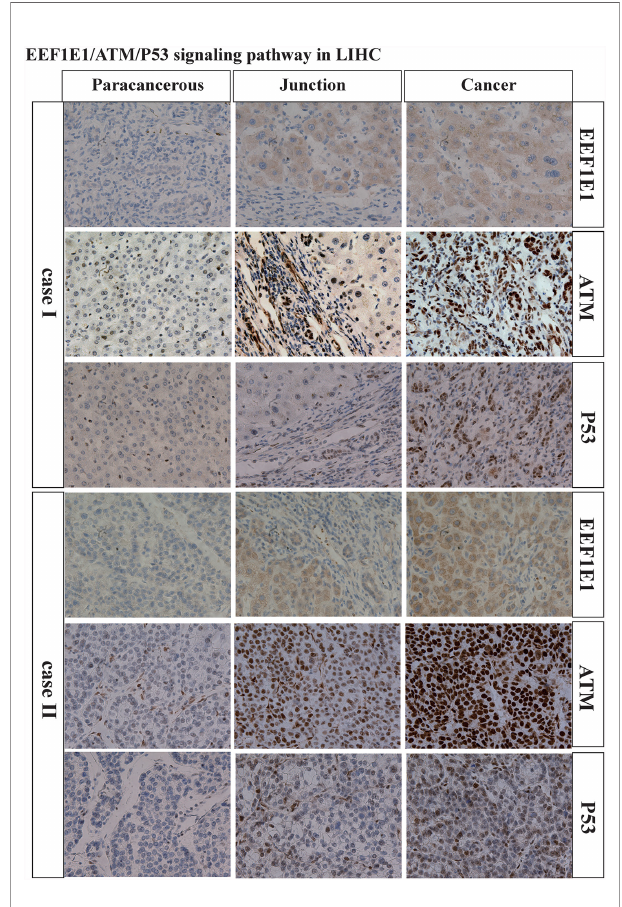
FIGURE 9 | Immunohistochemically veri fi cation of bioinformatics